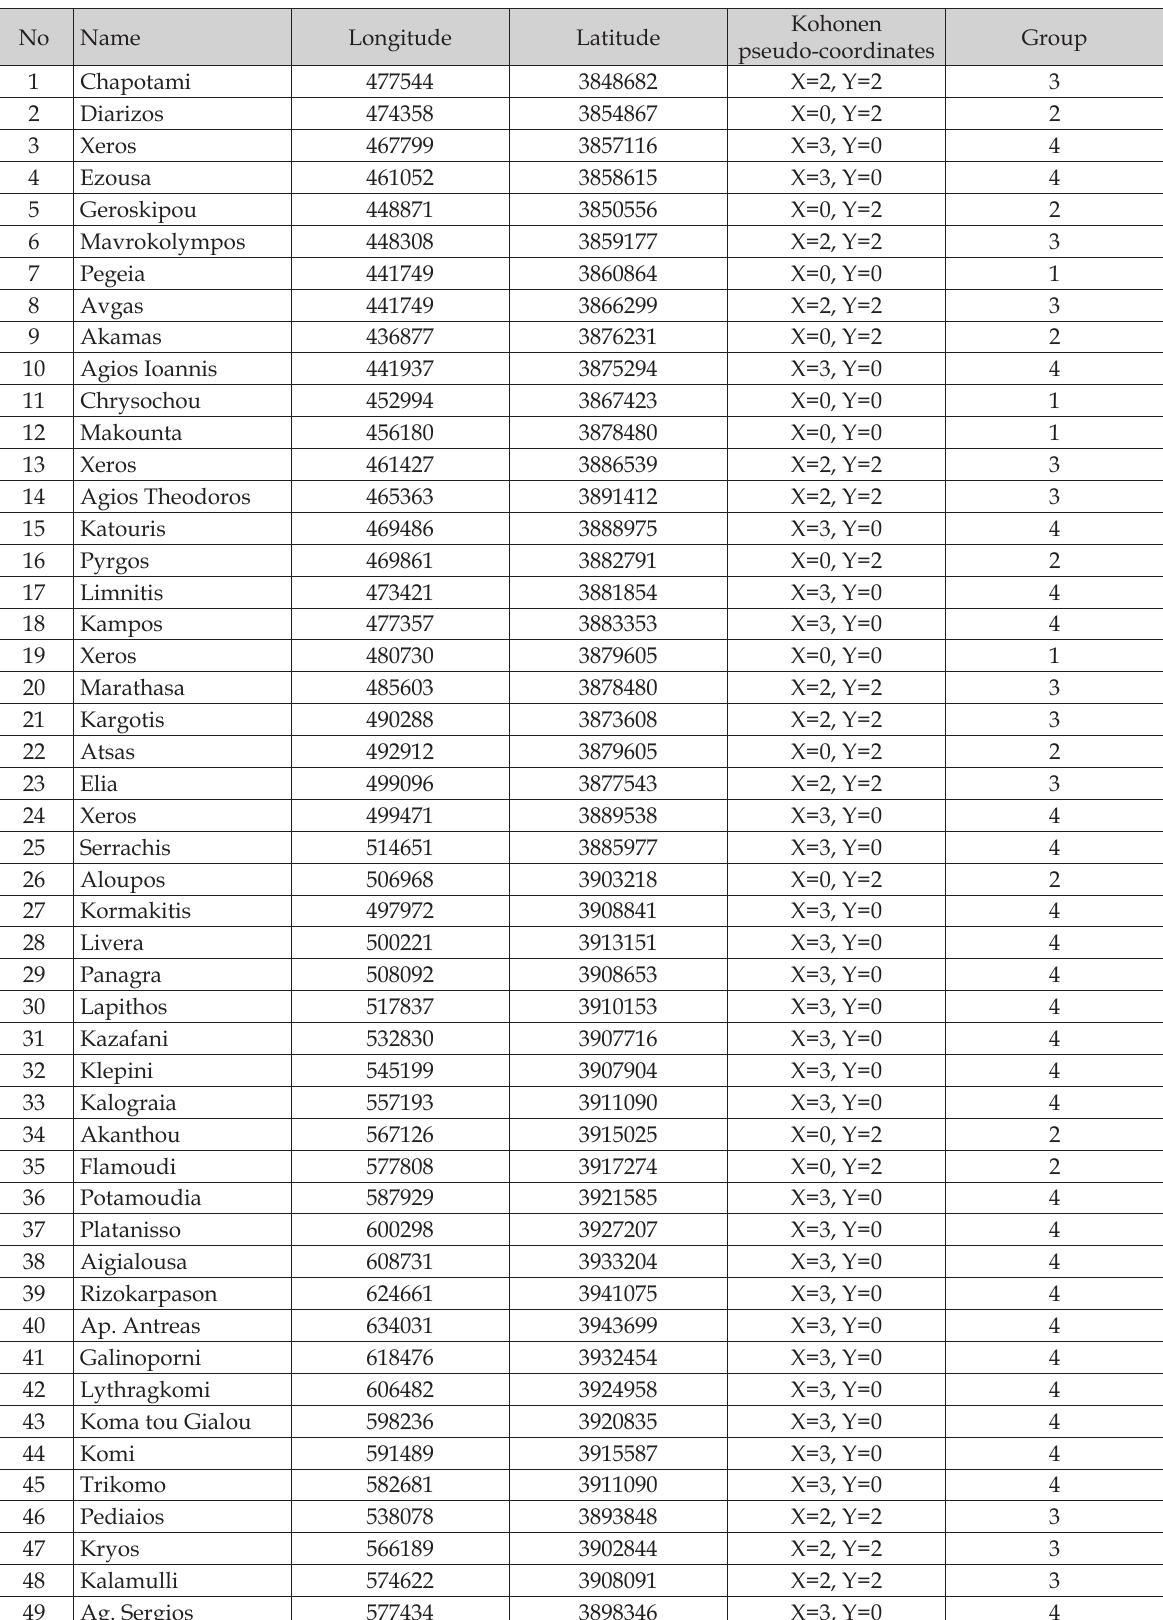
Table 6. Original classification of the 70 stations dataset (Kohonen’s